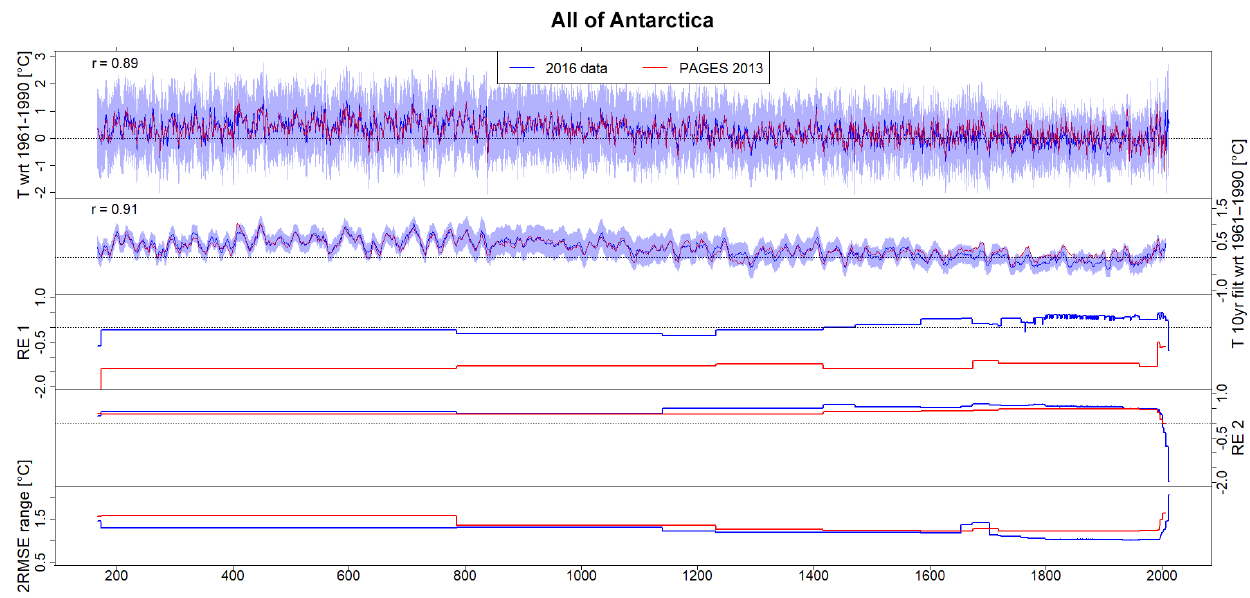
Figure 7. Comparison of CPS reconstructions of Antarctic mean temperatures over 167–2010CE. Red shows results from PAGES 2k Consortium (2013). Blue shows updated results using the new ice core isotope data collection described herein and the NB2014 temperature target. Blue shading shows 2RMSE uncertainties of the updated reconstruction. The top panel shows unfiltered interannual reconstructions. The second panel shows the 10-year running mean of reconstructions. The third (fourth) panel shows reduction of error skill from a split calibration verification exercise using 1961–1976 for calibration (verification) and 1977–1991 for verification (calibration). The bottom panel shows the 2RMSE reconstruction uncertainty